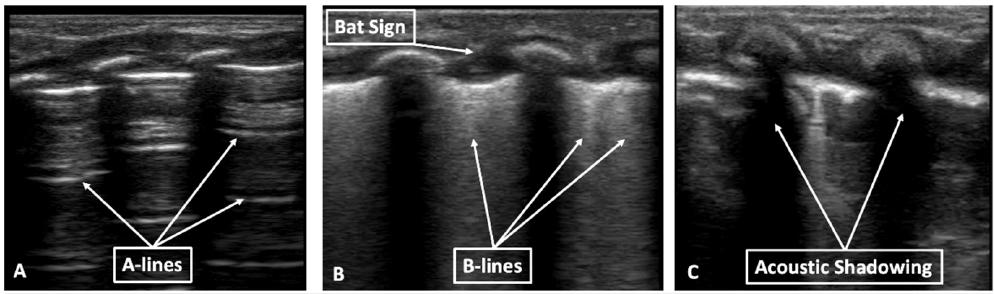
Figure 2. Lung ultrasound in B-mode. ( A ) A-lines, reverberation artifact from pleural line ( B ) B-lines, reverberation artifact from interstitial edema; ( C ) acoustic shadowing from the ribs.